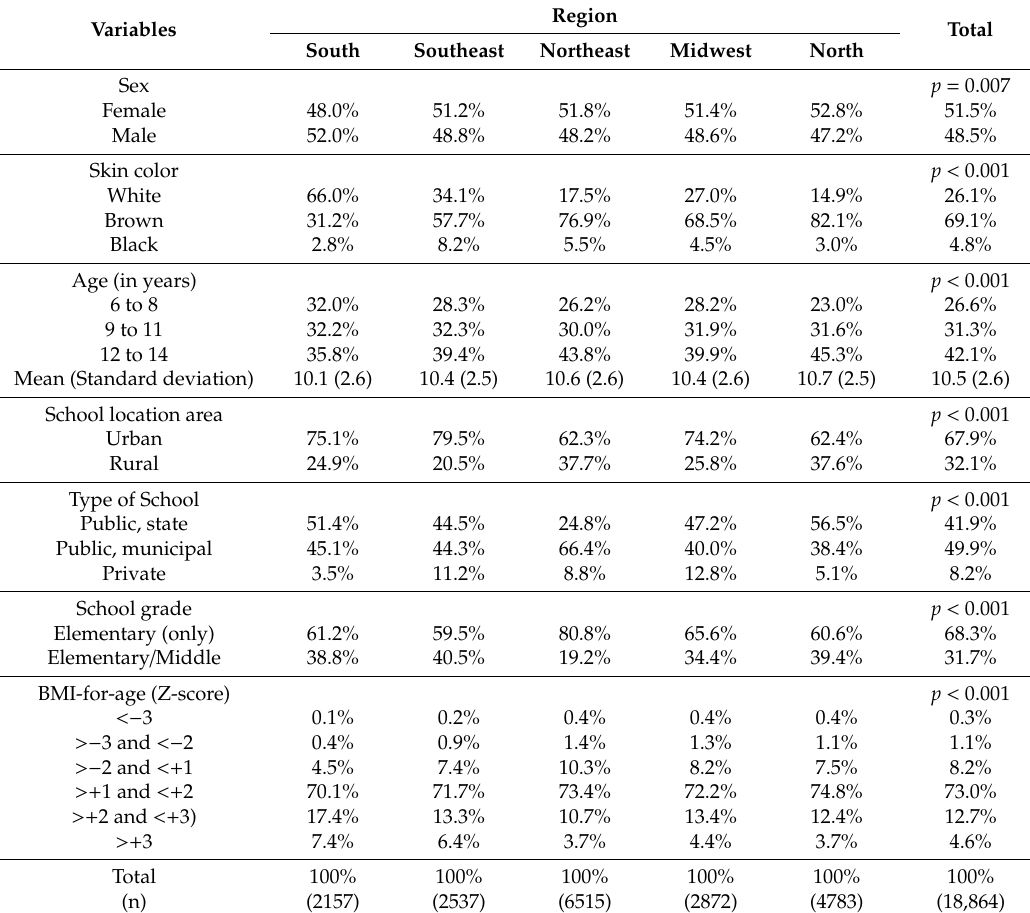
Table 2. Characteristics of schoolchildren aged 6 to 14 years by region, 2008–2014.